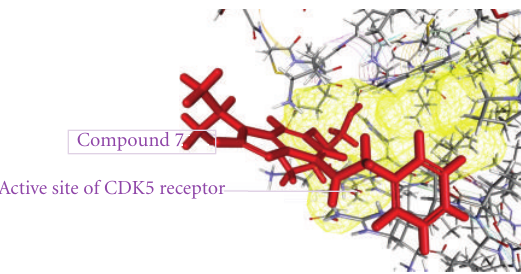
Figure 8: The docked conformation of compound 7 with the receptor CDK5/p25 (PDB: 3O0G). Compound 7 is indicated by red color while the most active site of the CDK5 receptor is shown with yellow